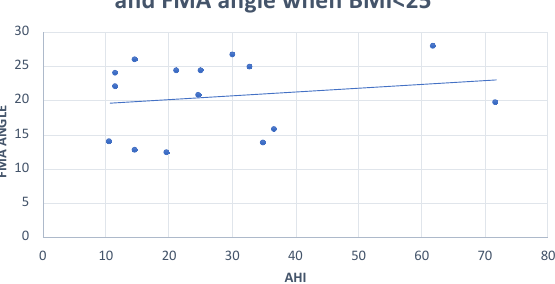
Figure 1. Scatter plot defining the relationship between AHI and FMA angle. r = 0.29.